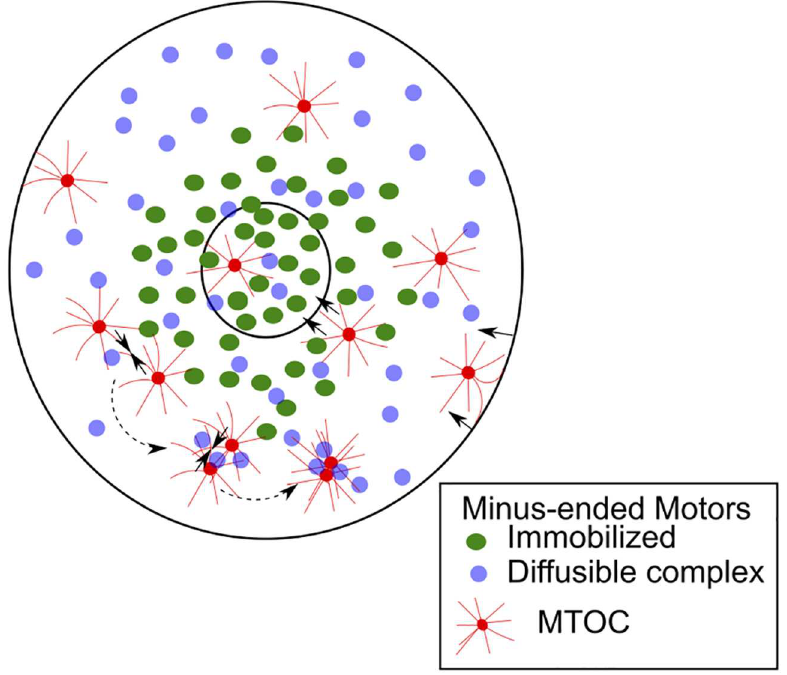
Fig 7. Mechanism of MT centering. An overview of our model of the centering motility of MTOCs (red) in a mouse-oocyte geometry. Net forces (solid arrows) arise from: inward inward pushingdue to MT bendingat the cell boundary, inward pullingdue to a gradientof immobilized motors around the chromatin space (green) and clustering by uniformly distributed diffusibleclustering motors (purple). The dotted arrows indicate the process of